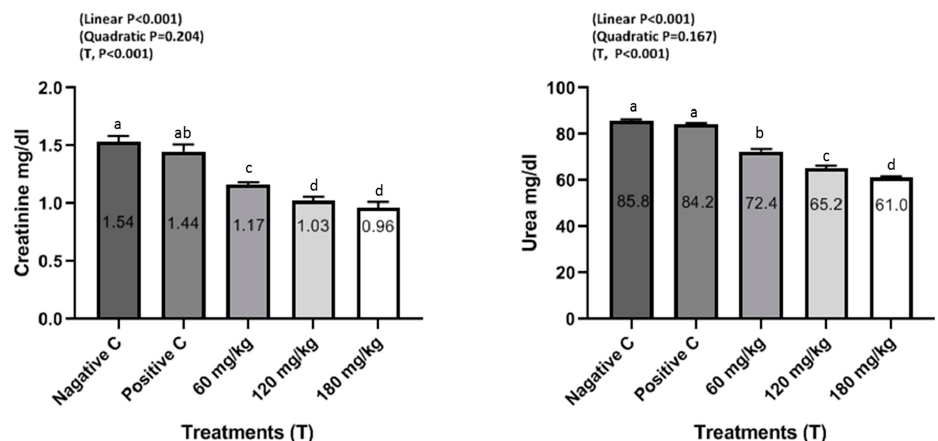
Figure 2. Liver enzyme (alanine transaminase (ALT) and aspartate transaminase (AST)) levels of male rabbits in response to dietary treatments including a basal diet (NC), a basal diet supplemented with a 500 mg/kg oxytetracycline antibiotic (PC), and a basal diet supplemented with 60, 120, or 180 mg/kg of TEO at 130 days of age. a–e Means within a row with different superscripts differ significantly at P < 0.05.